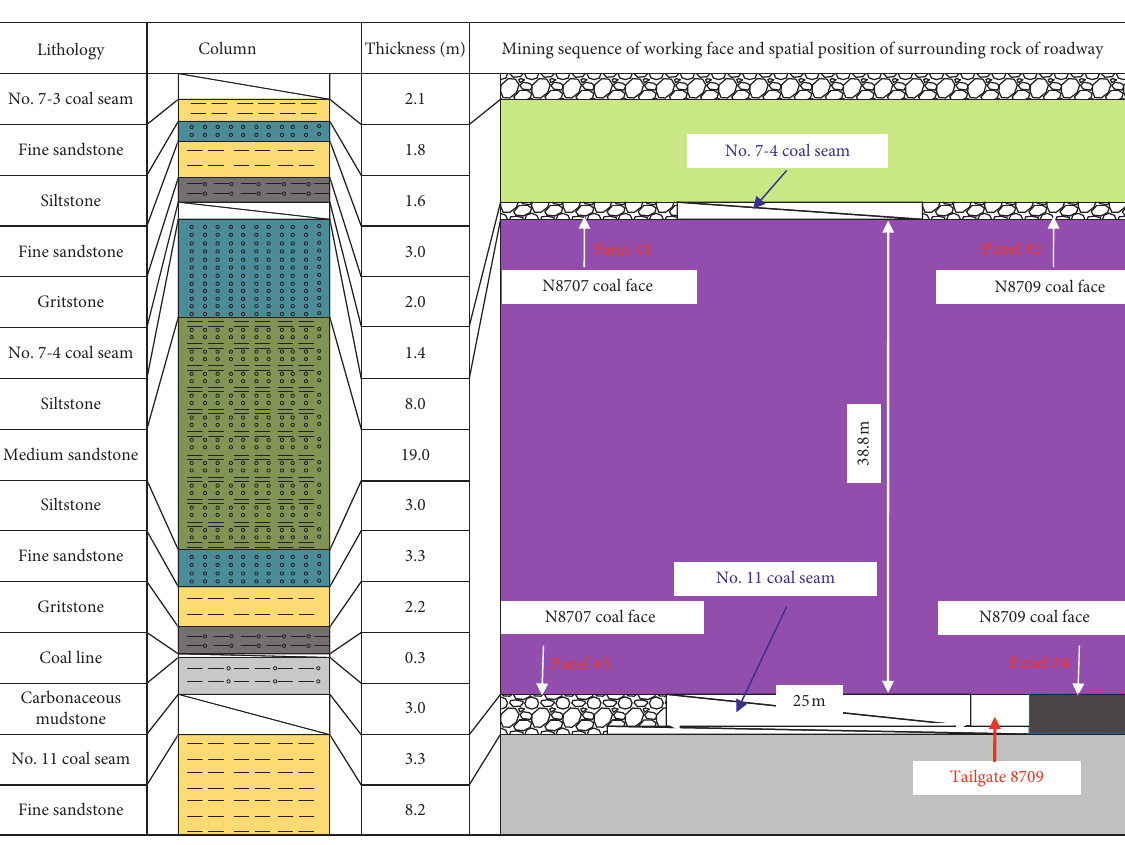
Figure 1: Lithology of the coal seam and mining sequence of each coal face.